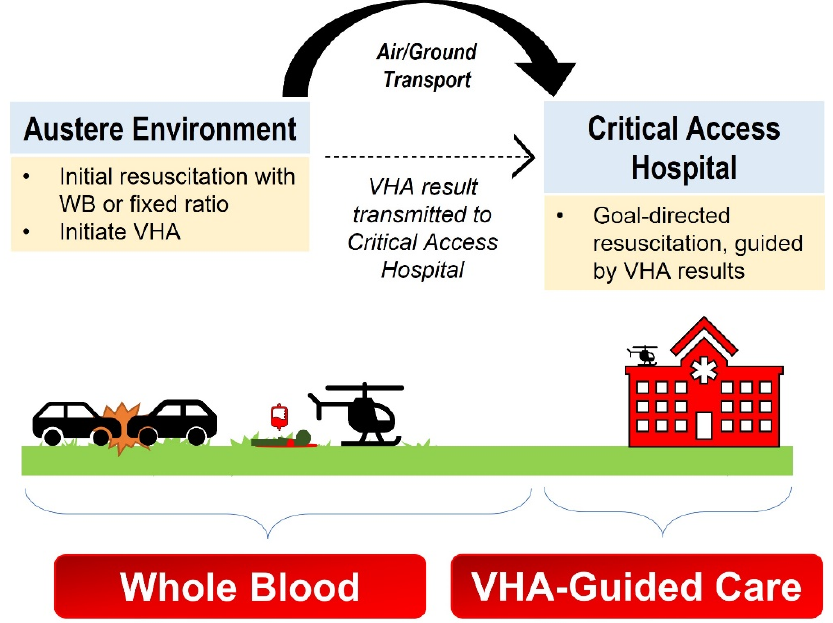
Figure 3. Proposed Use of VHA for Hemorrhagic Resuscitation in the Austere Civilian Environ- ment. The hemorrhaging patient is initially resuscitated with WB or fixed ratio according to local protocol. First responder medics obtain a blood sample and begin running a viscoelastic hemostatic assay (VHA) at the site of injury, which likely will result while the patient is in transport. The VHA result is transmitted to the Critical Access Hospital. Here, the austere VHA and new VHA upon arrival to the Critical Access Hospital enables continued resuscitation comprising goal-directed blood-component therapy.